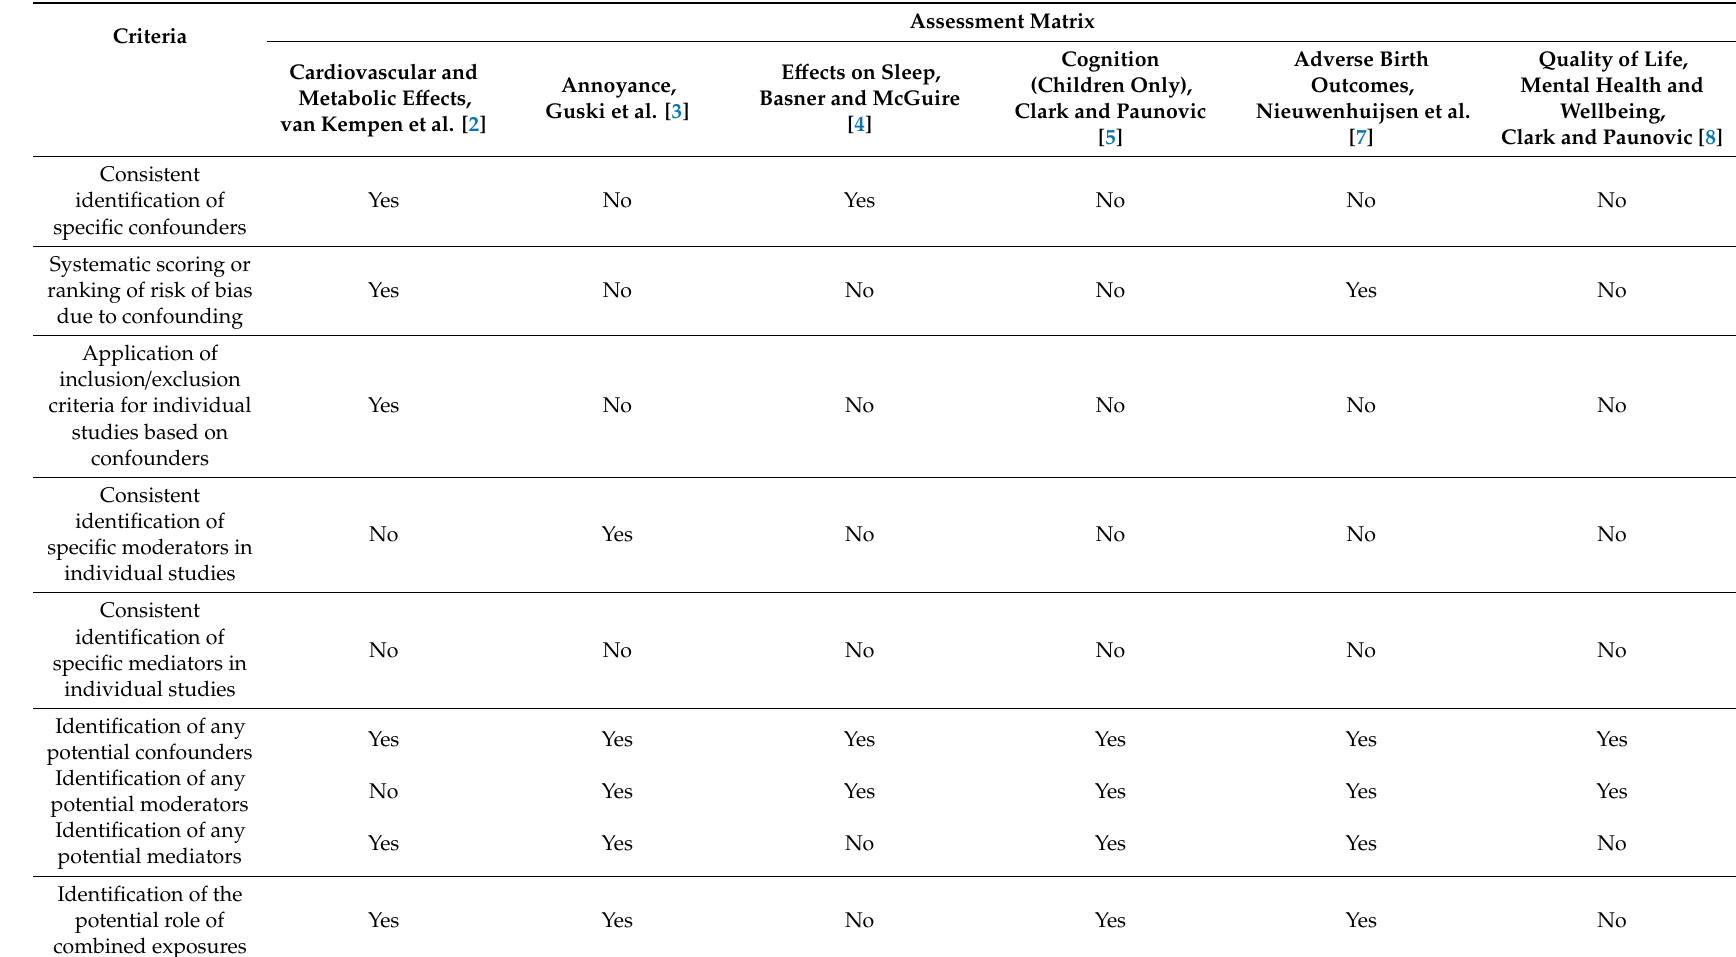
Table 7. Combined assessment